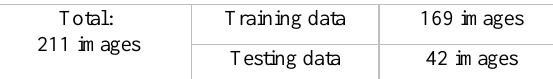
Figure8. The schematic diagram of the experiment Table2. The amount of data